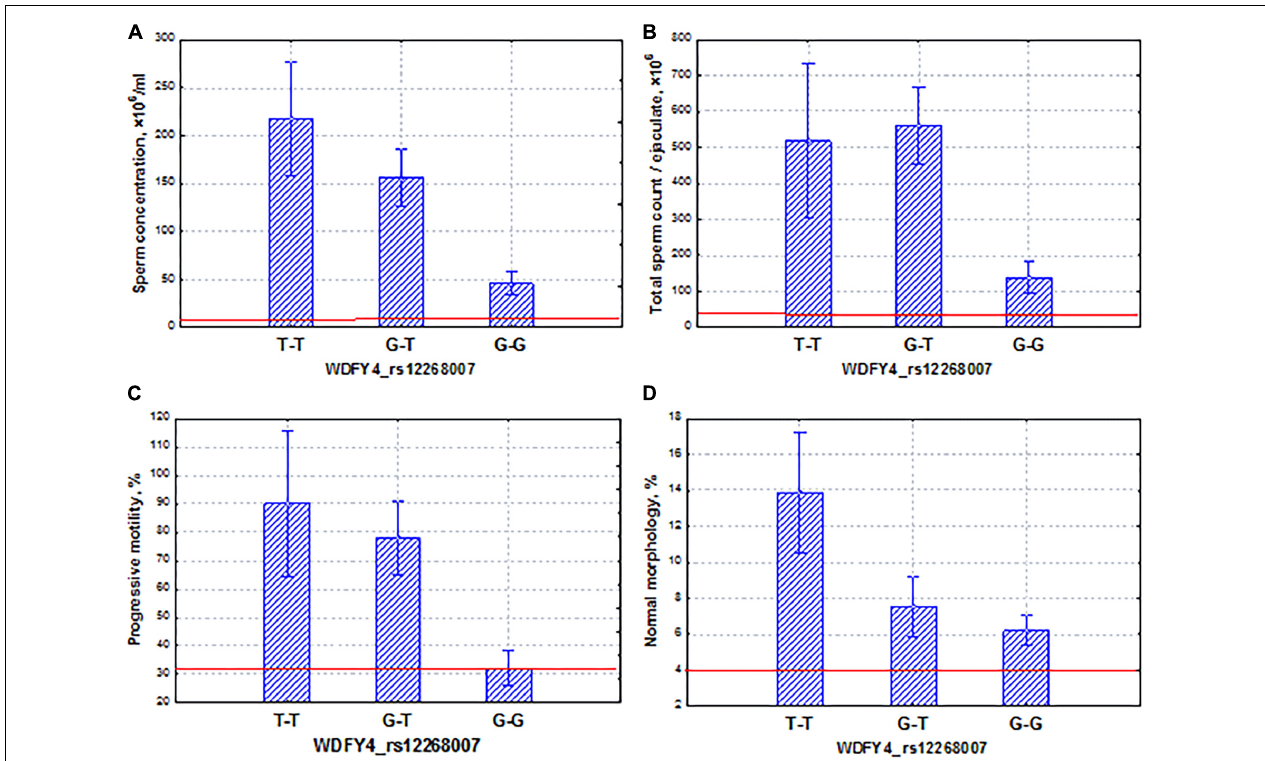
FIGURE 9 | Coordinated allelic effects of the SNP marker rs12268007 of the WDFY4 gene on semen quality parameters. (A) Sperm concentration, (B) total sperm count, and (C) proportion of motile, and (D) morphologically normal sperm. All the allelic differences were highly significant ( p < 0.005). The red lines indicate the WHO reference limits for different normal semen parameters [World Health Organization (WHO),